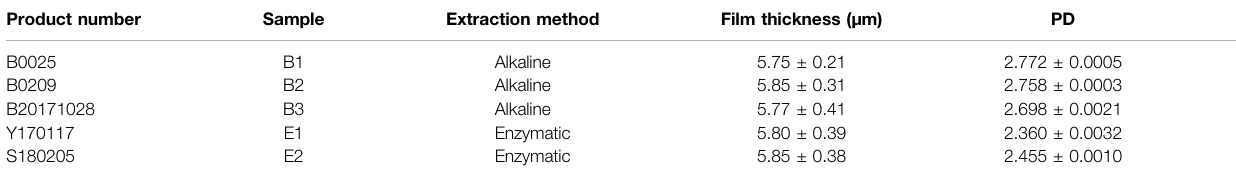
TABLE 1 | Physicochemical properties of different types of gelatin used in this study. Film thickness and PD were taken as average values. Product number